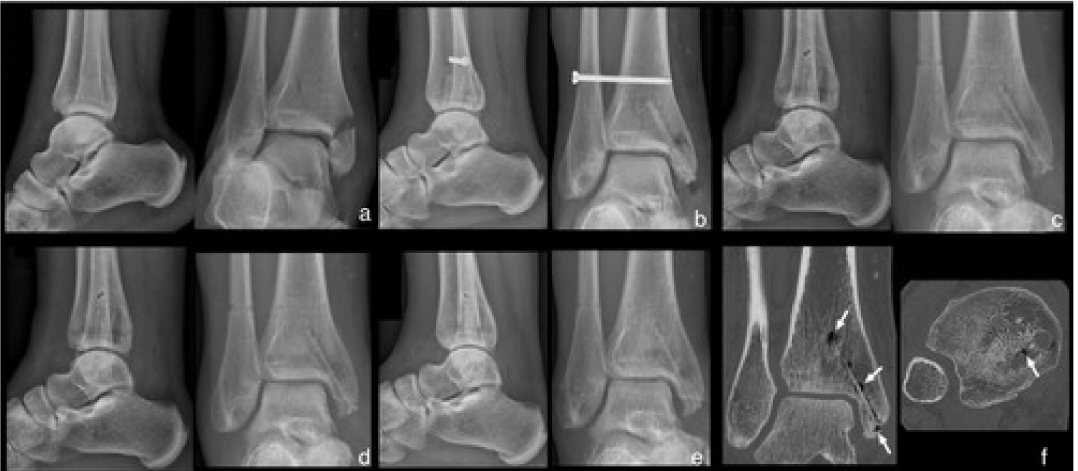
Figure 1. ( a ) Anteroposterior and lateral ankle radiographs of a 49-year-old female patient with medial malleolar fracture treated with Mg-based screws. ( b ) After 2 weeks: visible fracture line at the medial malleolus associated with small signs of radiolucent zones within the bone surrounding the screws. ( c ) After 6 weeks: fracture consolidation with increase of radiolucent zones within the bone surrounding the screws. ( d ) After 12 weeks, and ( e ) After 24 weeks: constant and non-evolutive radiolucent zones. ( f ) CT scan at 52 weeks, decrease of radiolucent zones, increased endosteal bone mass, and periosteal bone ingrowth at the screw head (white arrow). Reproduced from [108]. Table 3. Summary of the clinical studies investigating Mg-based implant in the field of maxillo-facial surgery. Type of Type of n Intervention Authors Study Device